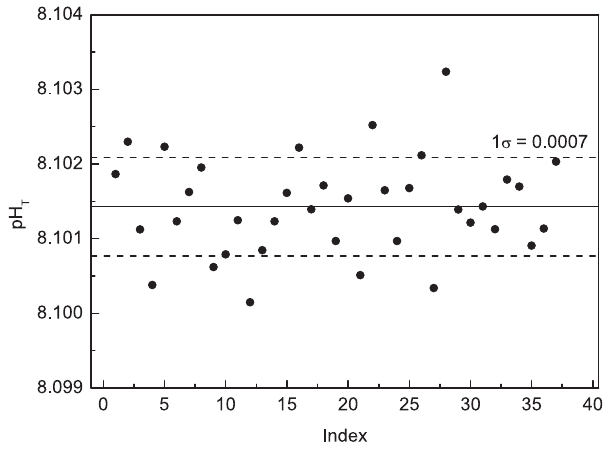
Fig. 7. Repetition measurements of a TRIS buffer based on the recipe in Dickson et al. (2007). The mean pH value is 8.1014 with a 1 σ standard deviation of ± 0 . 0007, N = 37. Index is the consecu- tive number of the repetition